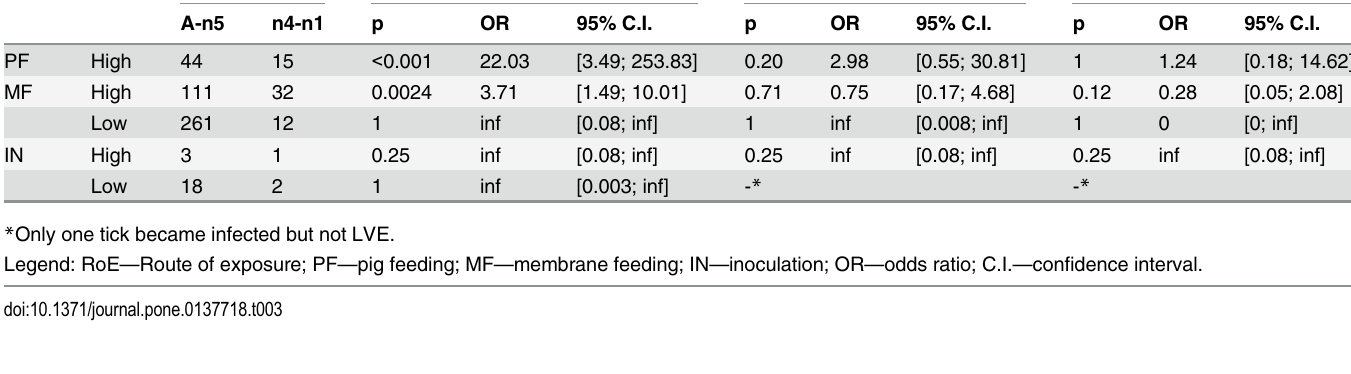
Table 3. Differences between tick stages, A-n5 versus small nymphs, for each outcome — infection, likelihood of virus excretion (LVE) and likeli- hood of virus excretion within infected ticks (LVE within infected ticks). RoE Titre Total stage Infection LVE LVE within infected ticks p OR 95% C.I. p OR 95% C.I. p OR 95%